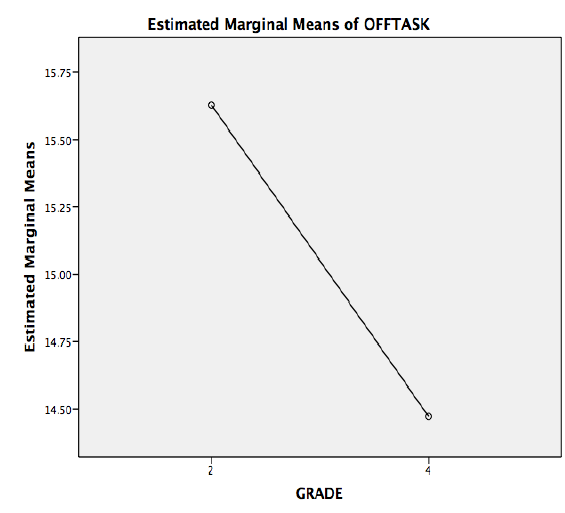
Figure 2. Profile plot of off-task behaviors